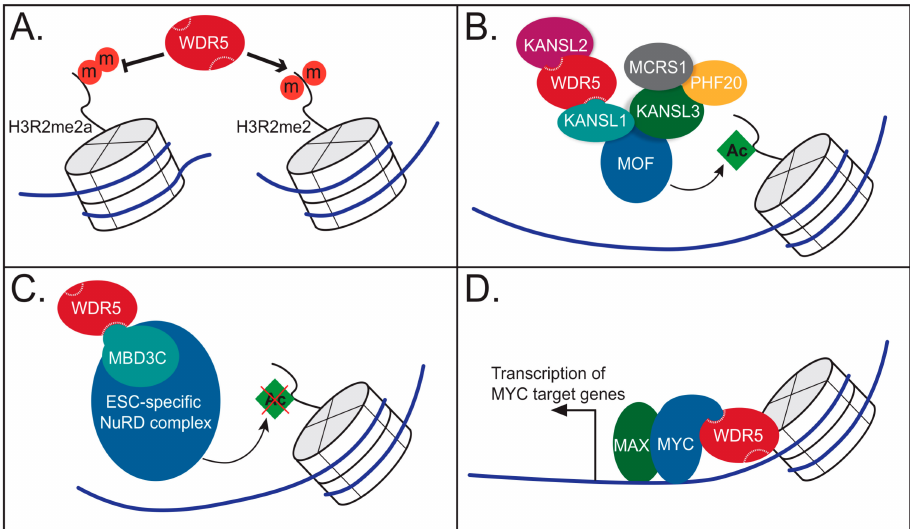
Figure 6. WDR5 has various roles at chromatin. ( A ) WDR5 binds directly to tails of histone H3 that are symmetrically dimethylated on Arg2. WDR5 binding is inhibited by the similar mark of asymmetrical dimethylation on Arg2. ( B ) WDR5 assembles in the non-specific lethal (NSL) complex, which acetylates histones. ( C ) WDR5 assembles in an embryonic stem cell-specific form of the nucleosome remodeling and deacetylase (NuRD) complex by binding to the MBD3C subunit. ( D ) WDR5 directly interacts with the transcription factor MYC to facilitate chromatin binding and transcriptional